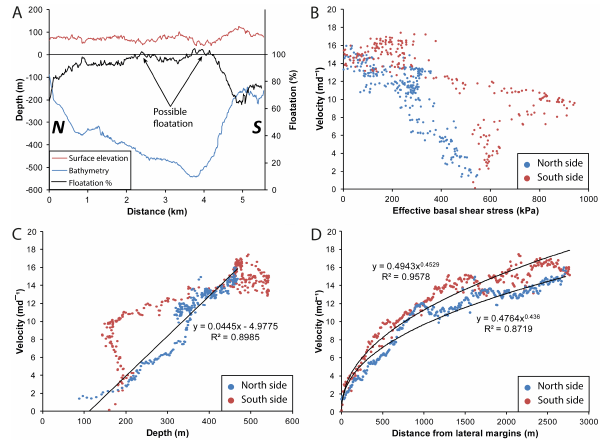
Figure 5. (a) Profiles showing the sea floor bathymetry and ice sur- face elevation at the calving front. These data were combined with surface velocities to estimate the ice flux of Store Glacier. Where the floatation percentage is over 100%, it is assumed that the ice is not thick enough to be fully grounded in hydrostatic equilibrium. (b) The relationship between effective basal shear stress and velocity. (c) The relationship between depth and velocity. At depths deeper than 400m, velocities are fairly constant. The two differing rela- tionships between 150 and 350m represent velocities from different sides of the glacier. (d) Relationship between velocity and distance from the lateral margins. The positive correlation demonstrates the importance of the resistance provided by the fjord